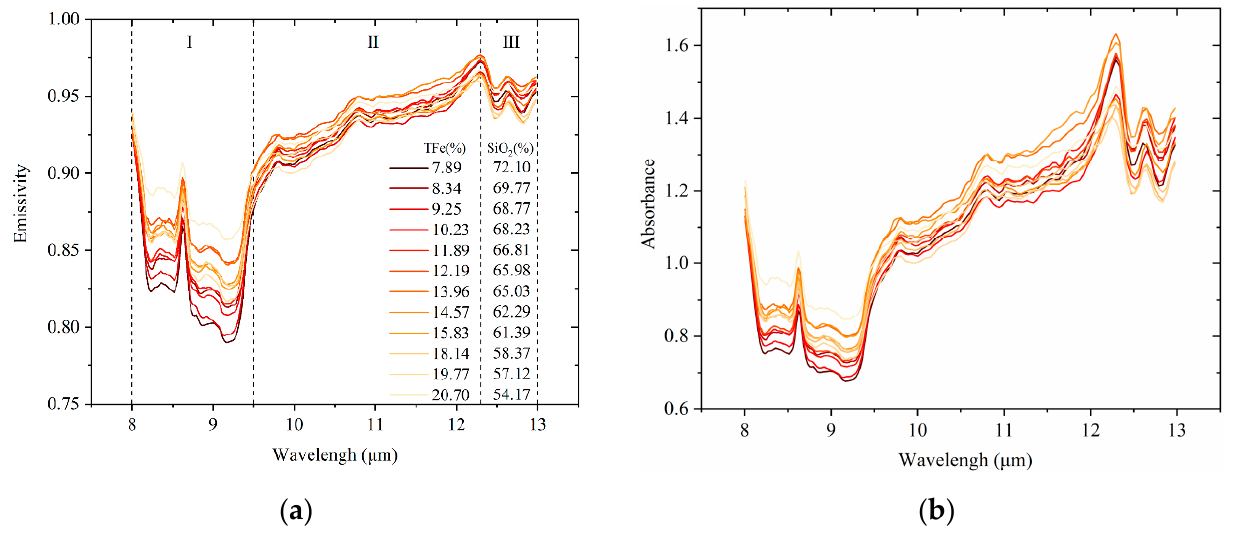
Figure 5. ( a ) The emissivity spectra of TFe and SiO 2 . ( b ) The absorbance spectra of TFe and SiO 2 in TIR.